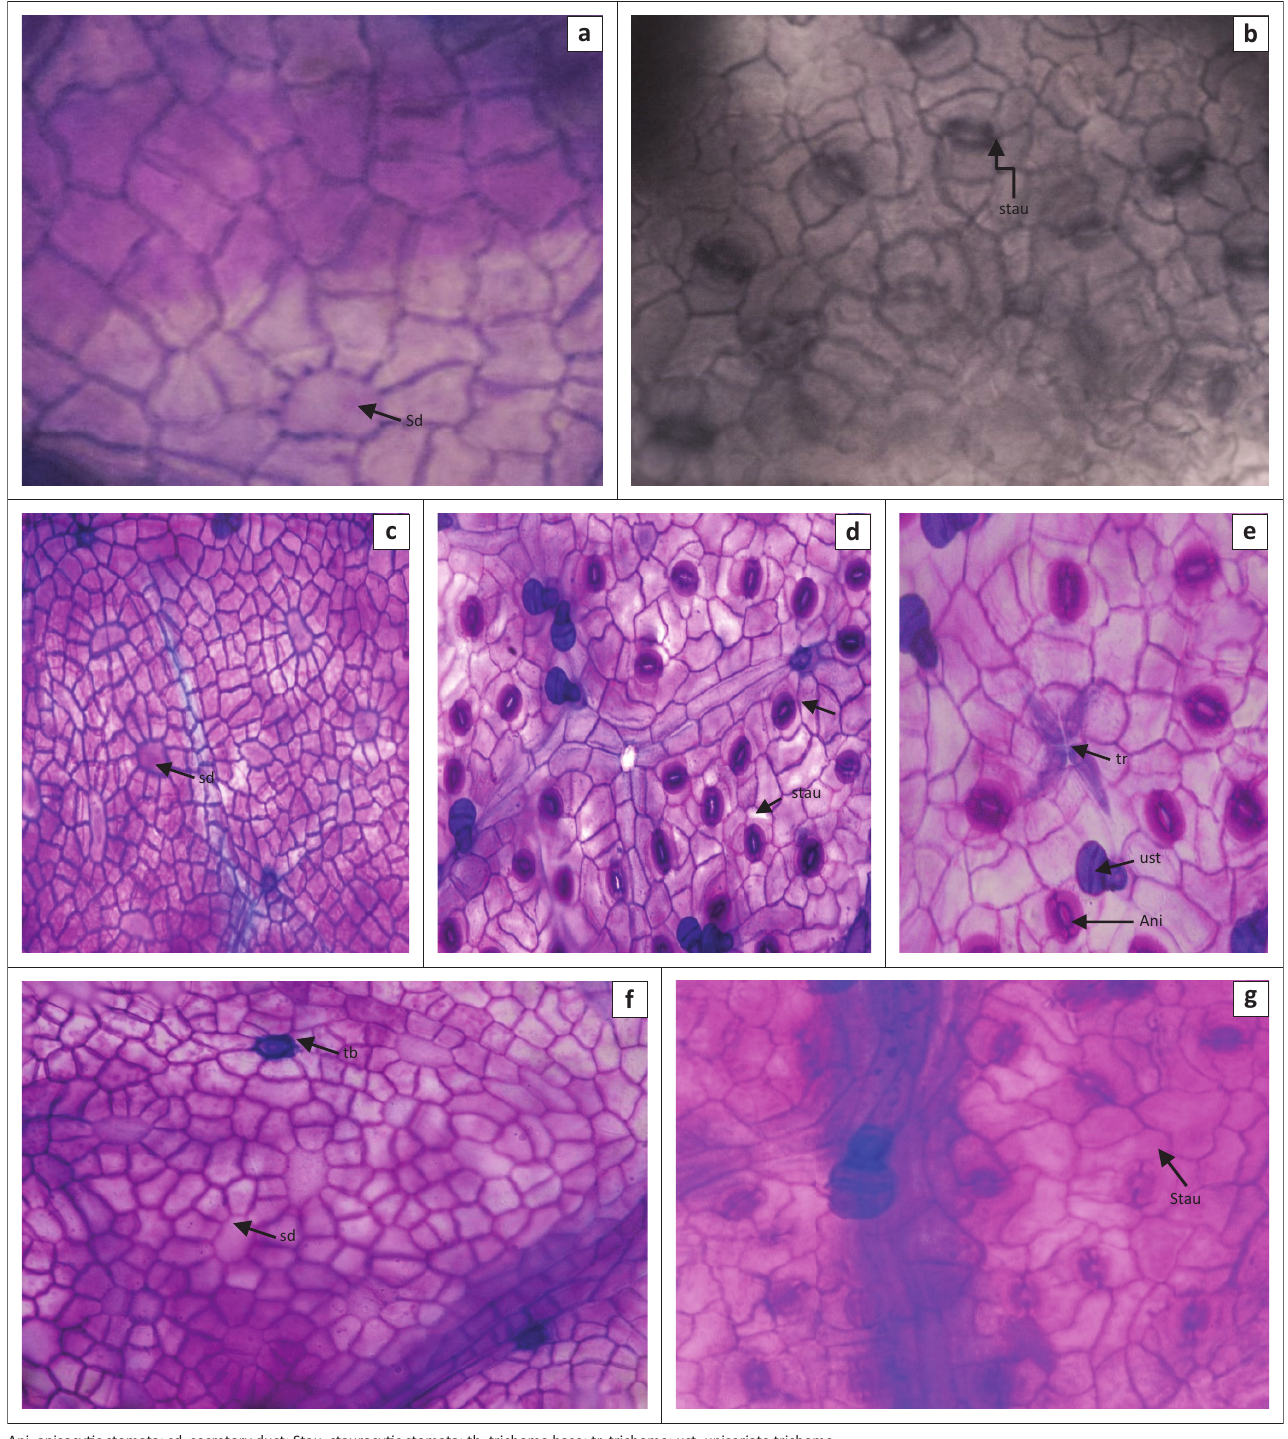
FIGURE 1: Microphotograph of the leaf epidermal surfaces of West African species of Desplatsia . (a) Desplatsia chrysochlamy , Adaxial showing secretory duct, straight, curved and wavy anticlinal cell wall; (b) abaxial surface showing staurocytic stomata, polygonal and irregular epidermal cells (c) D. dewevrei , adaxial surface showing secretory ducts and polygonal or irregular epidermal cells; (d) abaxial surface showing staurocytic stomata and trichome base on veins; (e) Abaxial showing curved to wavy anticlinal walls, 4-armed branched trichome, 2-celled head uniseriate glandular trichomes and anisocytic stomata; (f) D. subericarpa adaxial showing trichome base and secretory ducts; (g) abaxial surface showing staurocytic stomata and uniseriate glandular